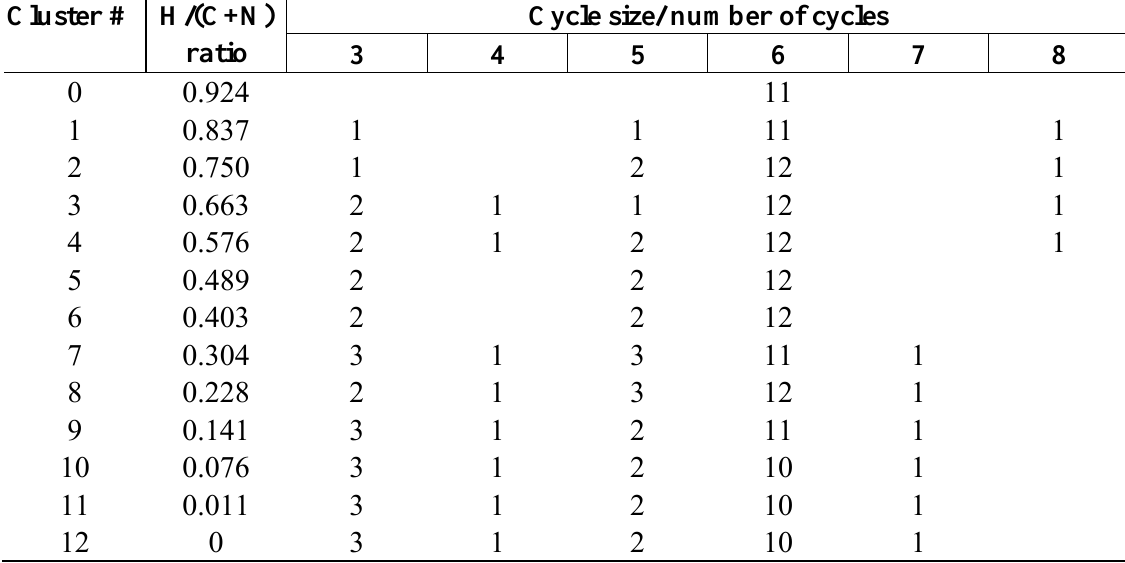
Table 2. The dependence of the cycles distribution in cluster models on the H/(C+N) ratio.